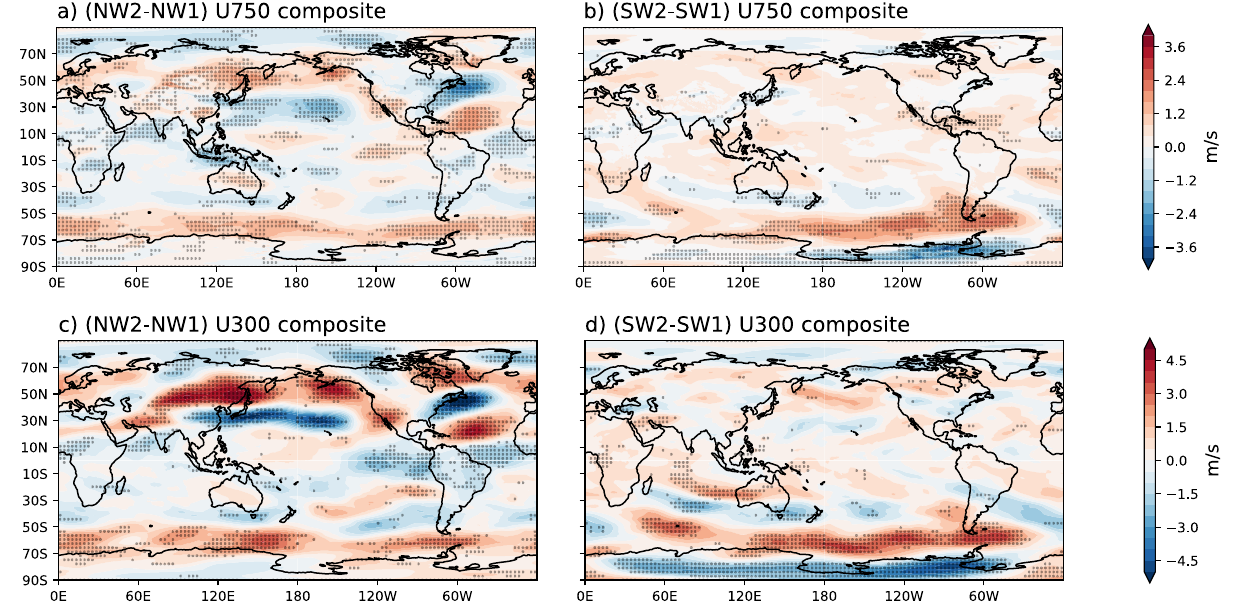
Fig. 6 U750 and U300 composites. As in Fig. 5 but for ( a , b ) U750 and ( c , d ) U300 (m s − 1